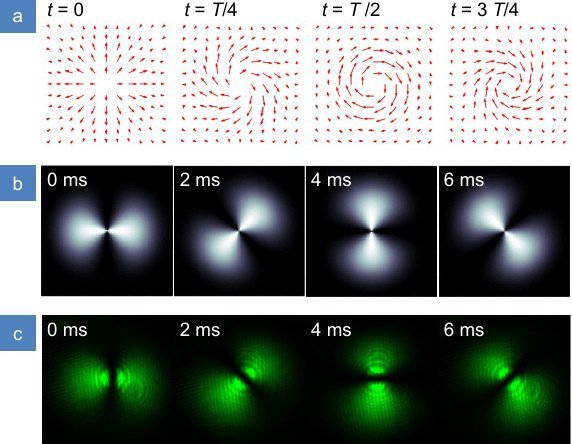
Fig. 3 | Verifying the polarization orientation distribution after passing through a LC-VP device. ( a ) Polarization angle distributions every T /4, where T is beat period that equals to 1/ ∆ f . ( b ) The simulat- ed light-field intensity distributions of the output trapping field recorded after passing the polarization detector consisting of a liquid crystal vortex half wave-plate and a polarizer when heterodyne frequency was set to 125 Hz. ( c ) The experimental light-field intensity distribu- tions recorded by a camera confirming that the polarization angle of the output trapping light rotated counterclockwise corresponding to (b) (Supplementary